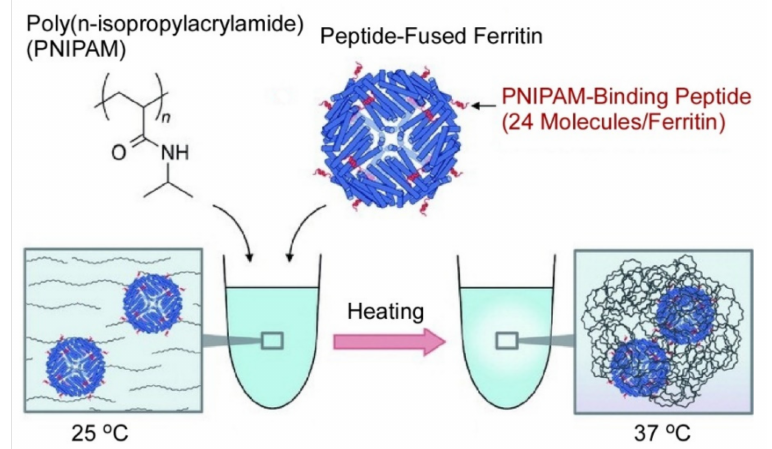
Figure 22. Complexes of ferritin and thermo-responsive polymer (poly(N-isopropylacrylamide)) formed with the aid of polymer-binding peptides. Reprinted with permission from Reference [167]. Copyright 2020 Chemical Society of Japan.